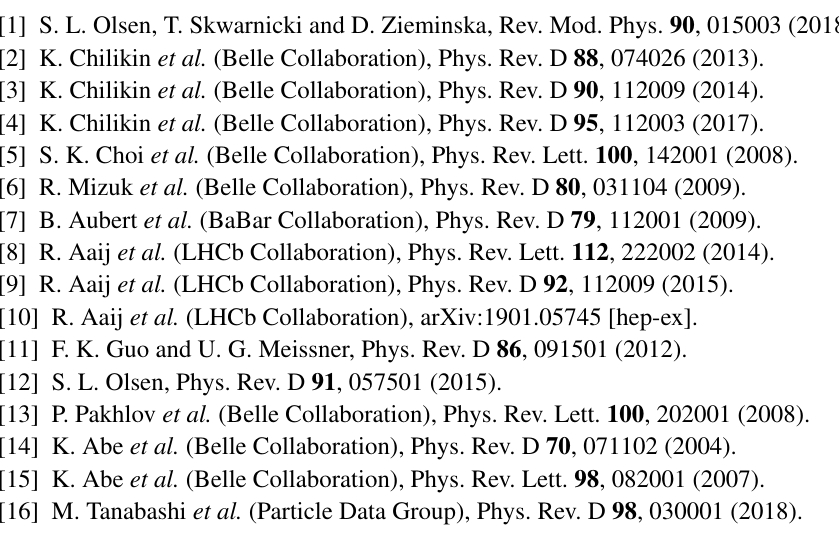
agree with the χ c 0 (2 P ) parameters determined from an alternative fit to the Belle and BaBar γγ → D ¯ D data